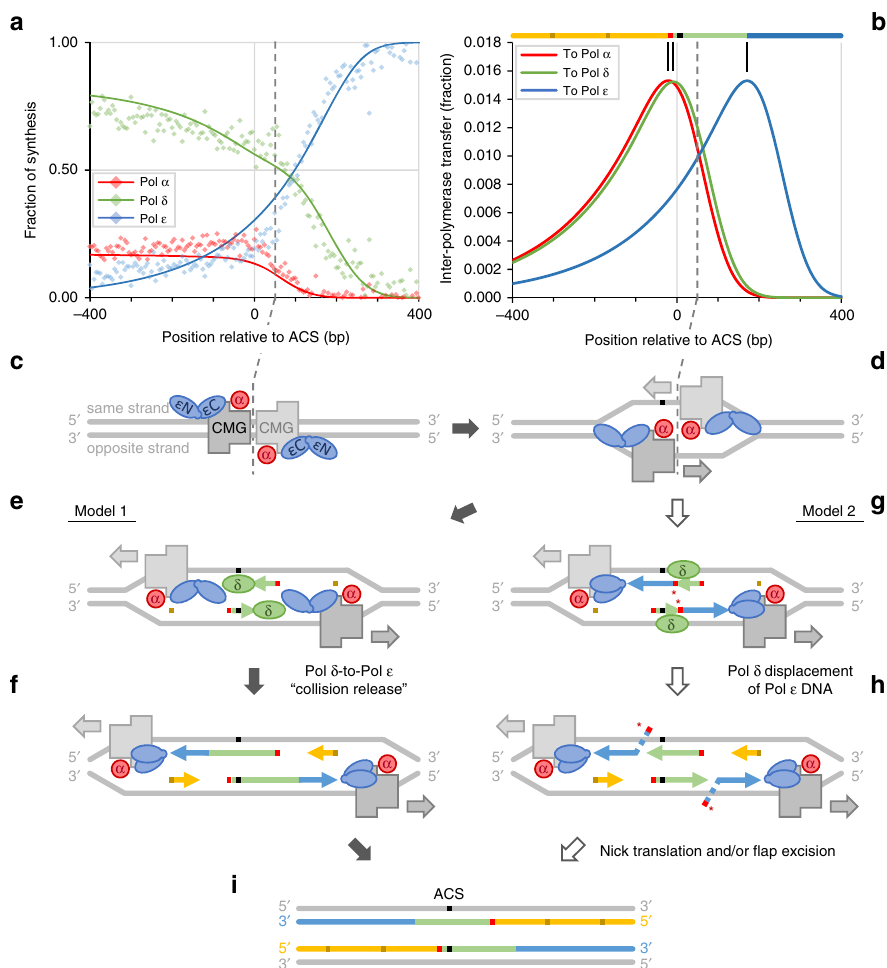
Fig. 4 HydEn-seq-derived evidence for DNA polymerase δ participation in leading-strand synthesis at yeast origins. Red, green, and blue